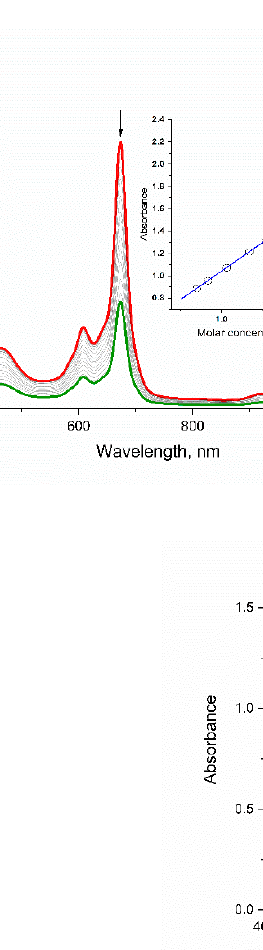
Molecules 2021 , 26 , x FOR PEER REVIEW 9 of 14